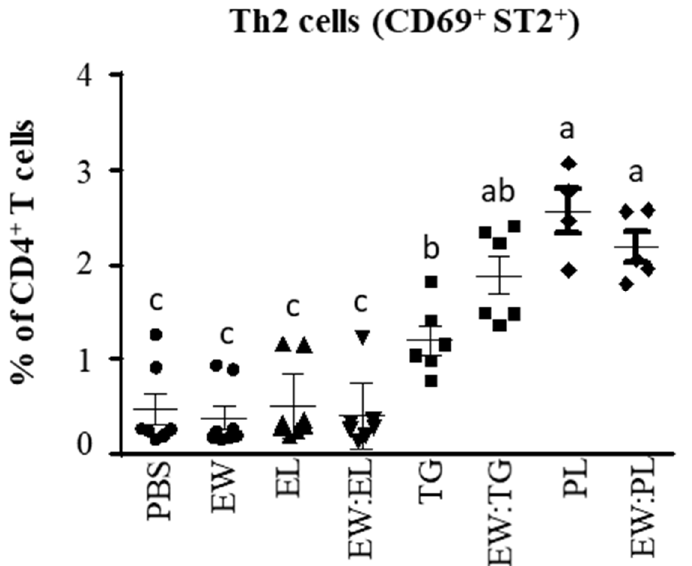
Figure 6. Activated (CD69 + ) ST2 + cells within CD4 + T cells in the MLNs of mice intragastrically administered PBS, egg white (EW, 50 mg), egg lipids (EL, 60 mg), a triacylglyceride-enriched fraction (60 mg, TG), a phospholipid-enriched fraction (60 mg, PL), and their mixtures (50 mg:60 mg) with EW (respectively EW:EL, EW:TG, EW:PL) for 6 consecutive days. Data are expressed as means ± SEM ( n = 6). Different letters indicate statistically significant differences ( p < 0.05) among different mouse groups.